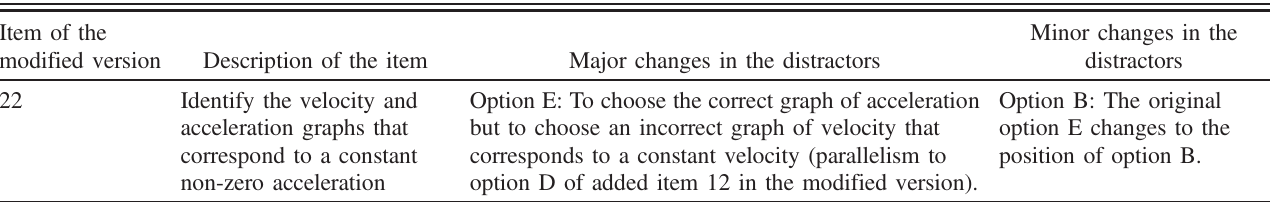
TABLE VIII. Description of the modifications and the reasons behind these modifications in the items with major and minor changes in the distractors (item 22; see Table III). Note that in the group of items one major change in the distractors was